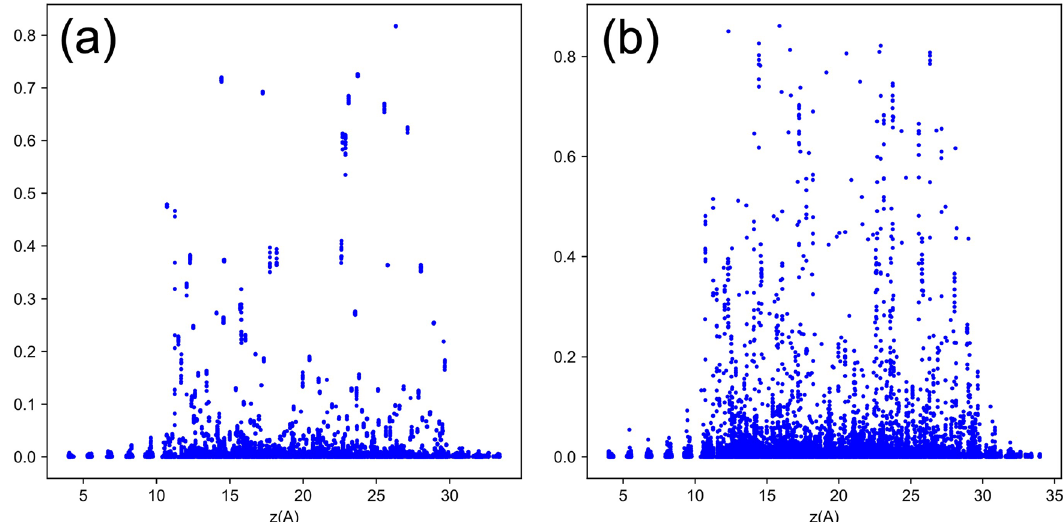
Fig. 11 Defect characterization at the c-Si/a-Si:H interface. IPR of atoms at the c-Si/a-Si:H interface and in aSi:H regions ( a ) before and ( b ) after a hydrogen atom is taken out of a dangling bond and placed at a Si – Si bond